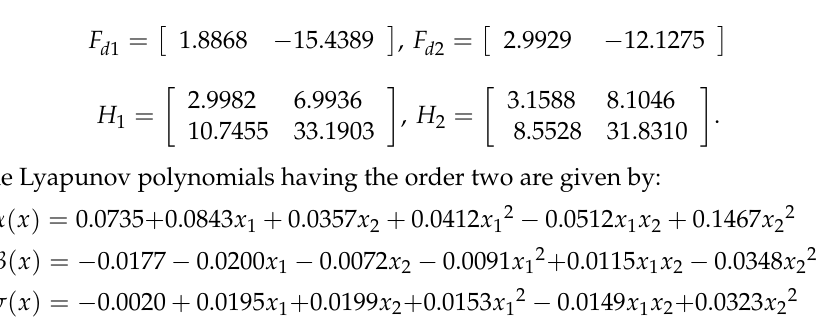
. Figure 13. Regions stability for m = 100 and δ =